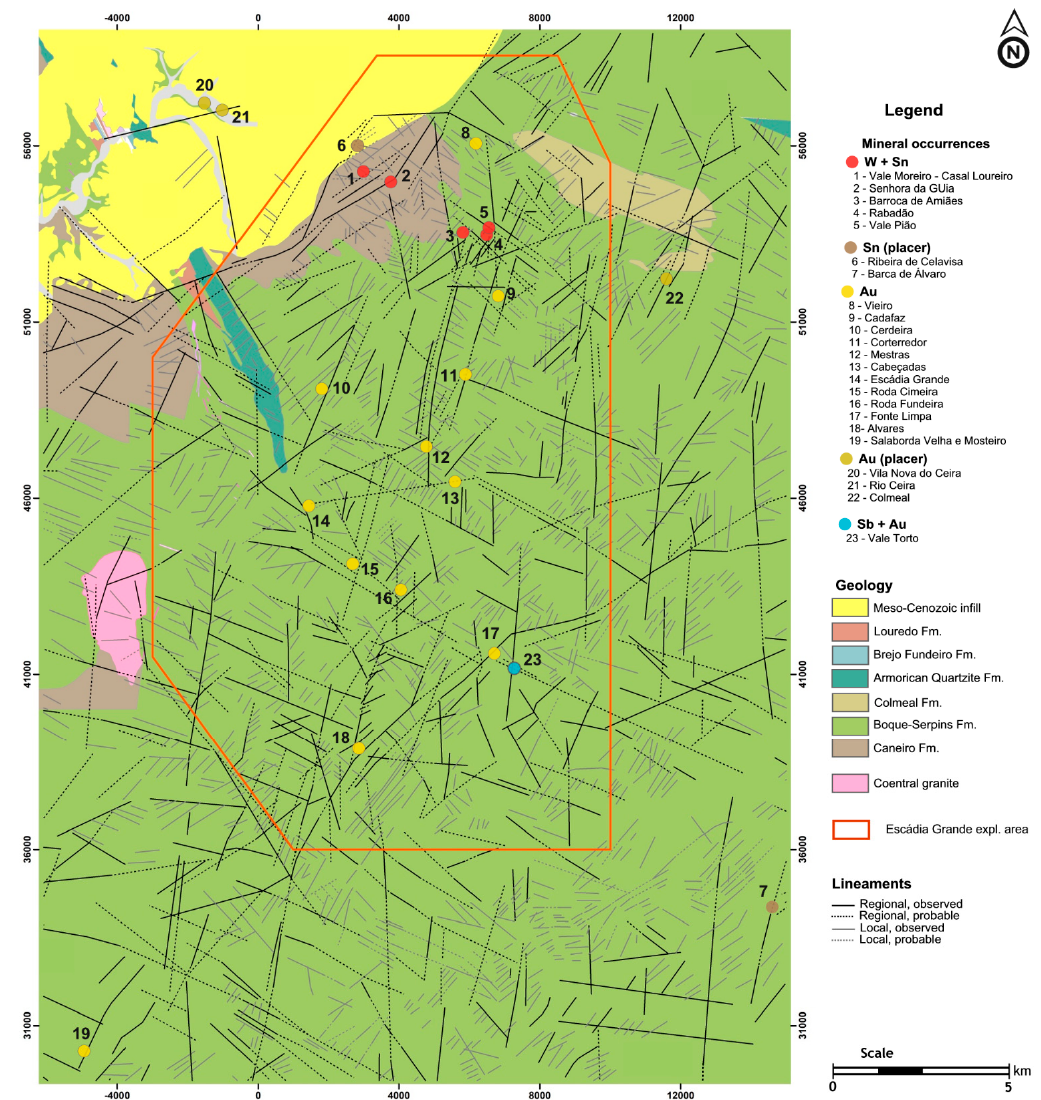
Figure 18. Mapped lineaments and known mineral occurrences.